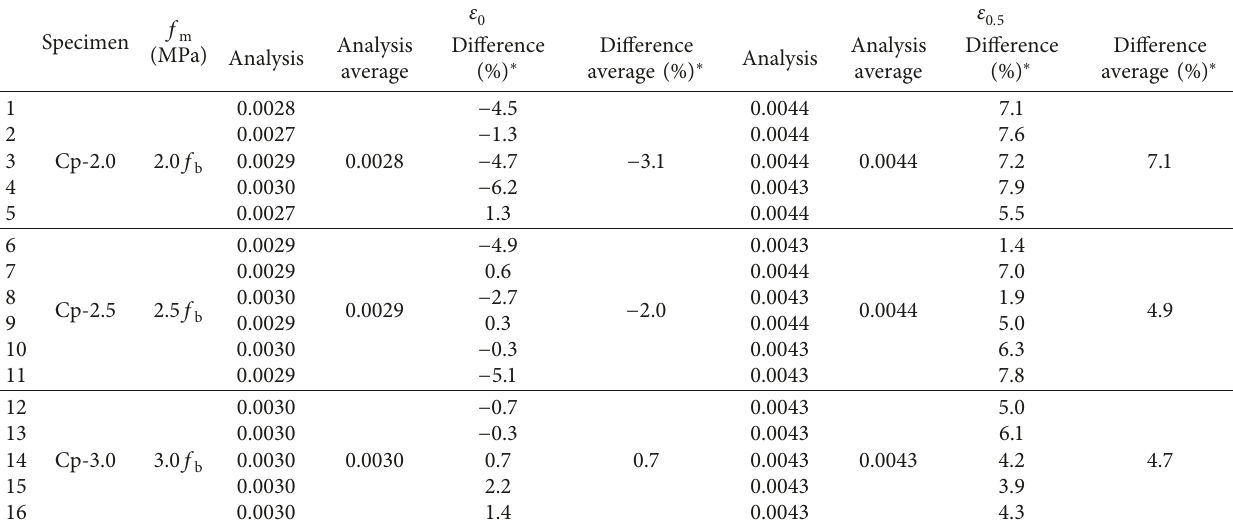
Table 5: Comparison of ε 0 and ε 0 . 5 from test and analysis.